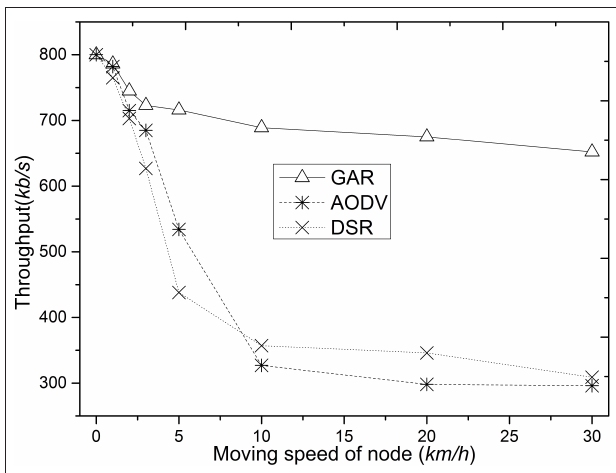
FIGURE 4 | Comparison of throughput as node speed increases.